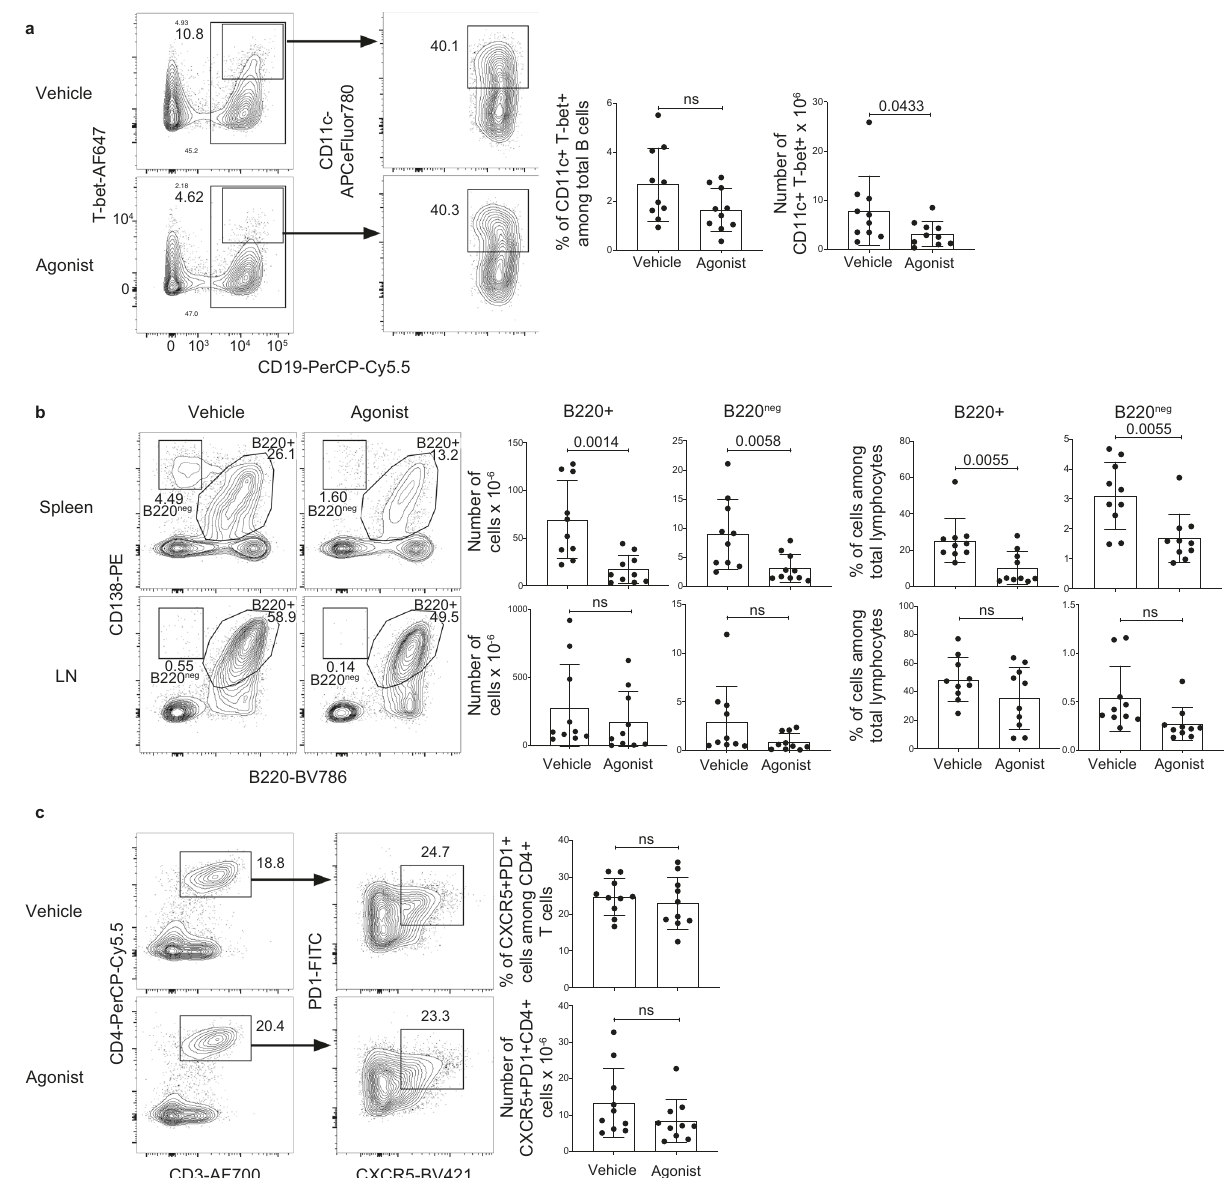
Fig. 4 A 2A receptor agonism reduced the number of pathogenic lymphocytes after disease onset. a Female MRL/lpr mice were treated with vehicle ( n = 10) or agonist ( n = 10) twice weekly, starting at 12 weeks of age; splenocytes were analyzed at 20 weeks of age. The zebra plots and graphs show the percentages and numbers of T-bet + CD11c + CD19 + B cells. Statistical signi fi cance was determined using either a two-tailed unpaired t -test (left graph) or a Mann – Whitney test (right graph). b Splenocytes and LNs from the mice in a were analyzed by fl ow cytometry. The contour plots and graphs show the percentages and numbers of CD138 + B220 + cells and CD138 + B220-negative cells in the spleens and LNs of analyzed mice. Statistical signi fi cance was determined using two-tailed unpaired t -tests with the Benjamini, Kieger, and Yekutieli two-stage step-up false discovery rate method. q -values are shown in the graphs. c Splenocytes from the mice in a were analyzed by fl ow cytometry. The contour plots and graphs show the percentages and numbers of PD- 1 + CXCR5 + CD4 + CD3 + cells. Statistical signi fi cance was determined using a two-tailed unpaired t -test (top graph) or a Mann – Whitney test (bottom graph). Columns and error bars indicate the arithmetic mean and